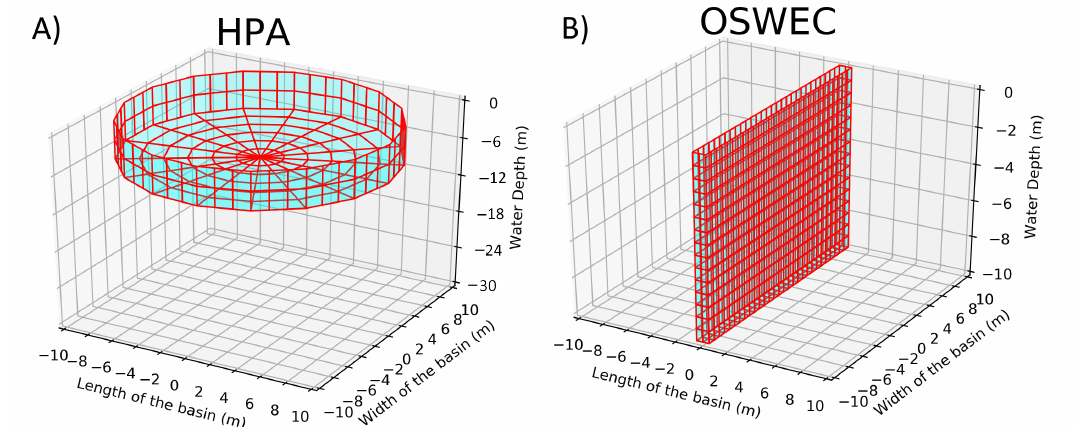
Figure 1. ( A ) Low-order mesh for the HPA WEC; and ( B ) low-order mesh for the